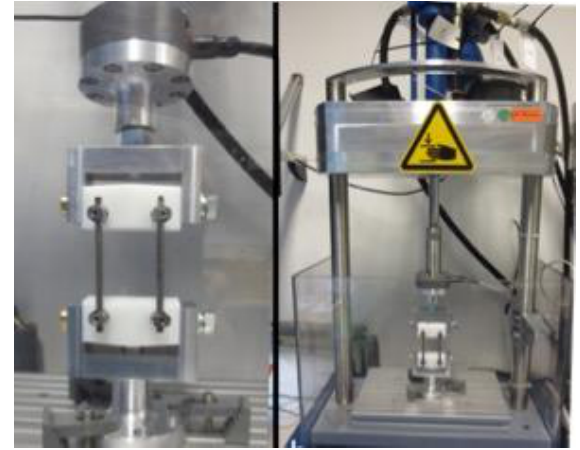
Figure 2. Frontal view of the fatigue testing setup.